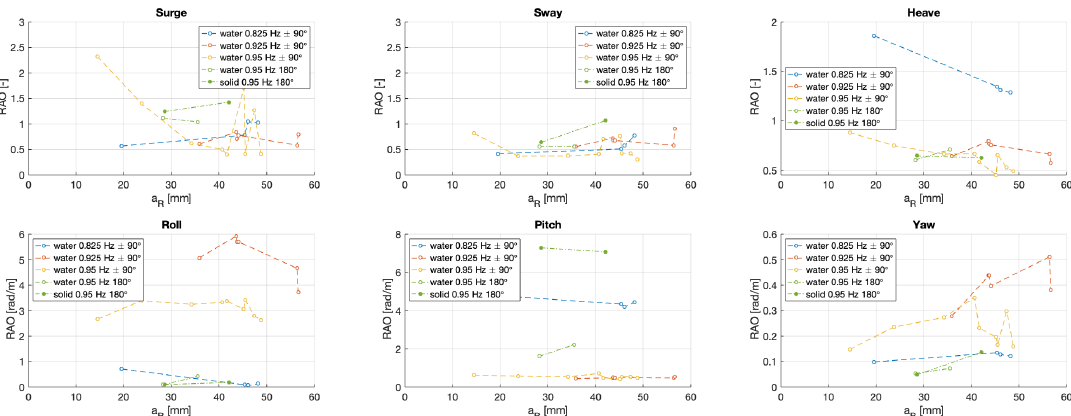
Figure 10. Amplitude response in the six DoF in relation to the measured wave amplitude